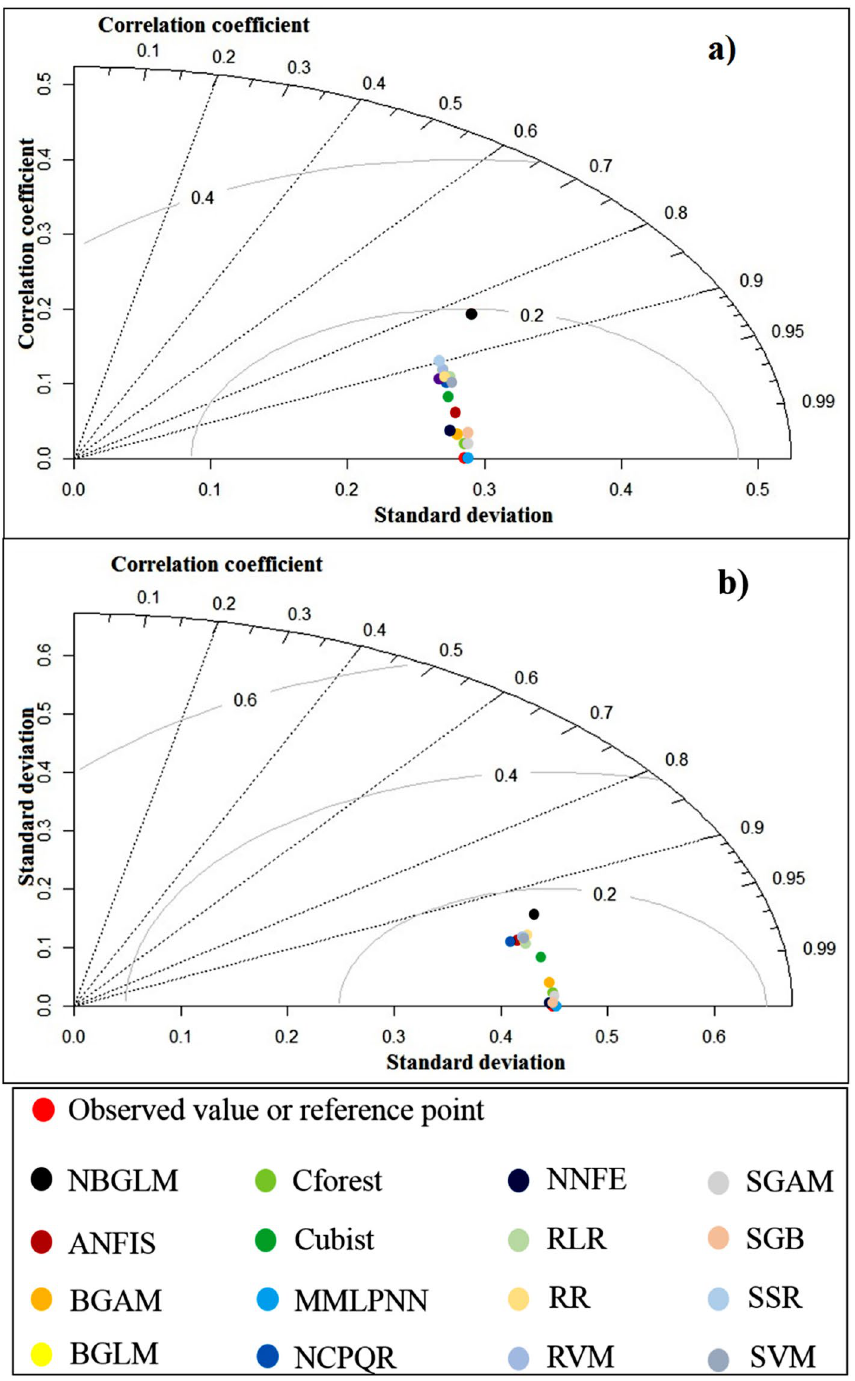
Figure 6. Taylor diagrams for assessing the performance of the models in this research; (a) training dataset, and (b) evaluation